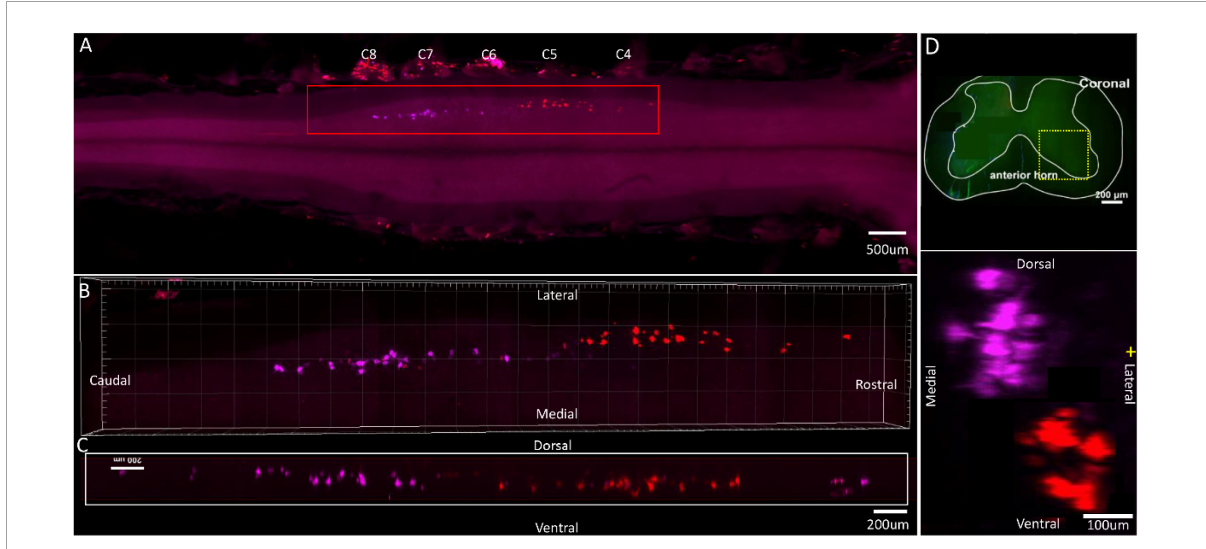
FIGURE6 Distribution characteristics of motor neurons targeting different muscles innervated by median nerves. Motor neurons innervating flexor carpi ulnaris (labeled by FR, purple), flexor digitorum profundus (ulnaris) (labeled by CTb-647, red). (A) Spatial images of multi-tracks in a holistic view. (B,C) The relative spatial positions of the motor neuron columns targeting different muscles in sagittal and corona viewing angles. (D) The schematic diagram of the distribution of different motor neuron columns in the anterior horn of the spinal cord. The yellow box that outlines the region of interest is amplified in the subpanels in panel (D) . The cross-sectional images are maximum projections of C5–C8. The motor neurons innervating flexor carpi ulnaris have little overlapping with flexor digitorum profundus